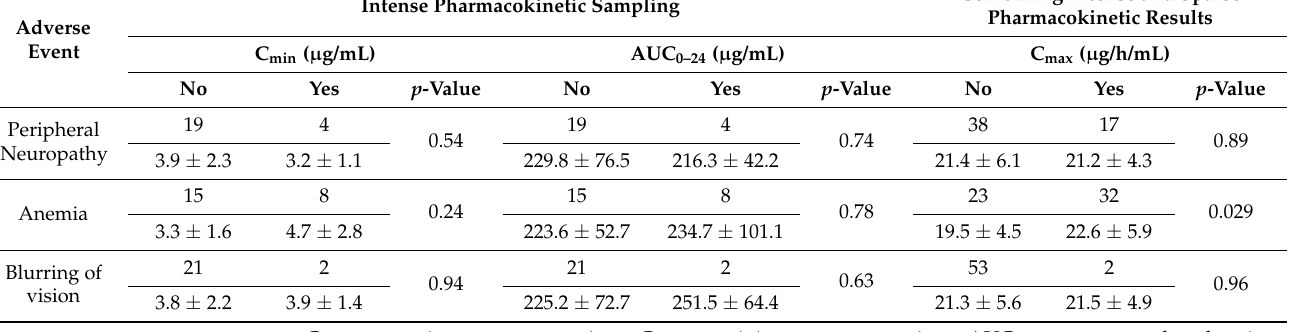
Table 3. Occurrence of adverse events and estimated pharmacokinetic parameters in the steady state (Cmin, Cmax, and AUC) among the study participants on a linezolid-containing regimen for drug-resistant